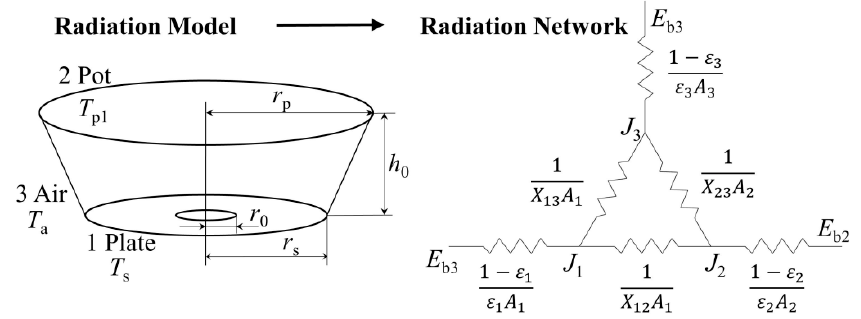
Figure 1. Radiation heat exchange system.